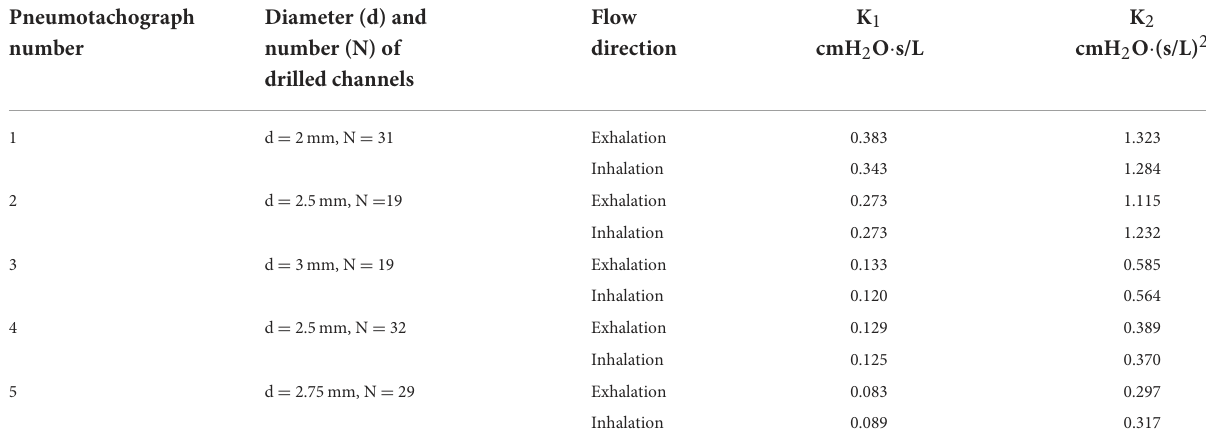
TABLE 1 K 1 and K 2 of the constructed